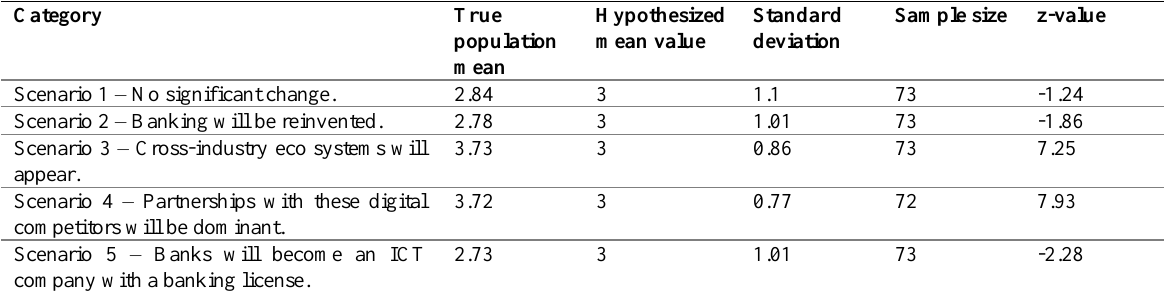
Table 5: Analysis of z-test results to assess the impact on Swiss banking business value chain Category True population